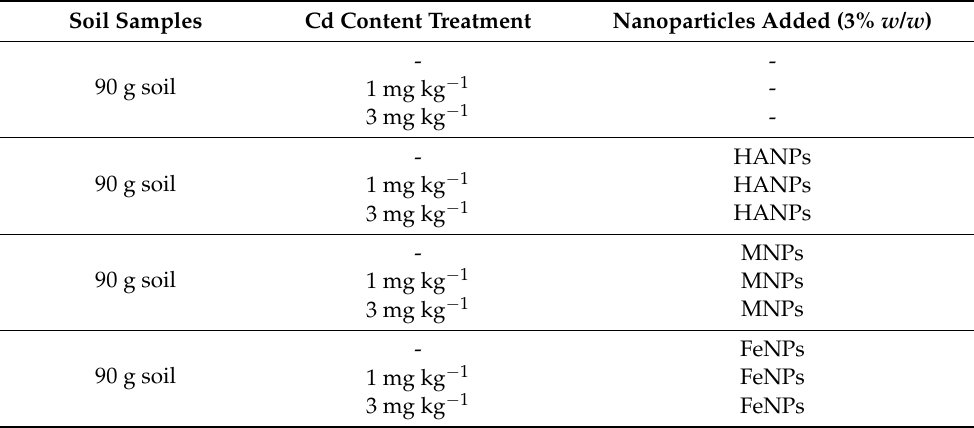
Table 5. Treatments for the different soil analyses with Cd and/or nanoparticles. Soil